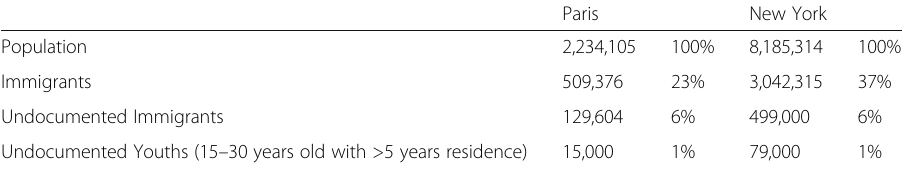
Table 1 Selected Populations, Paris and New